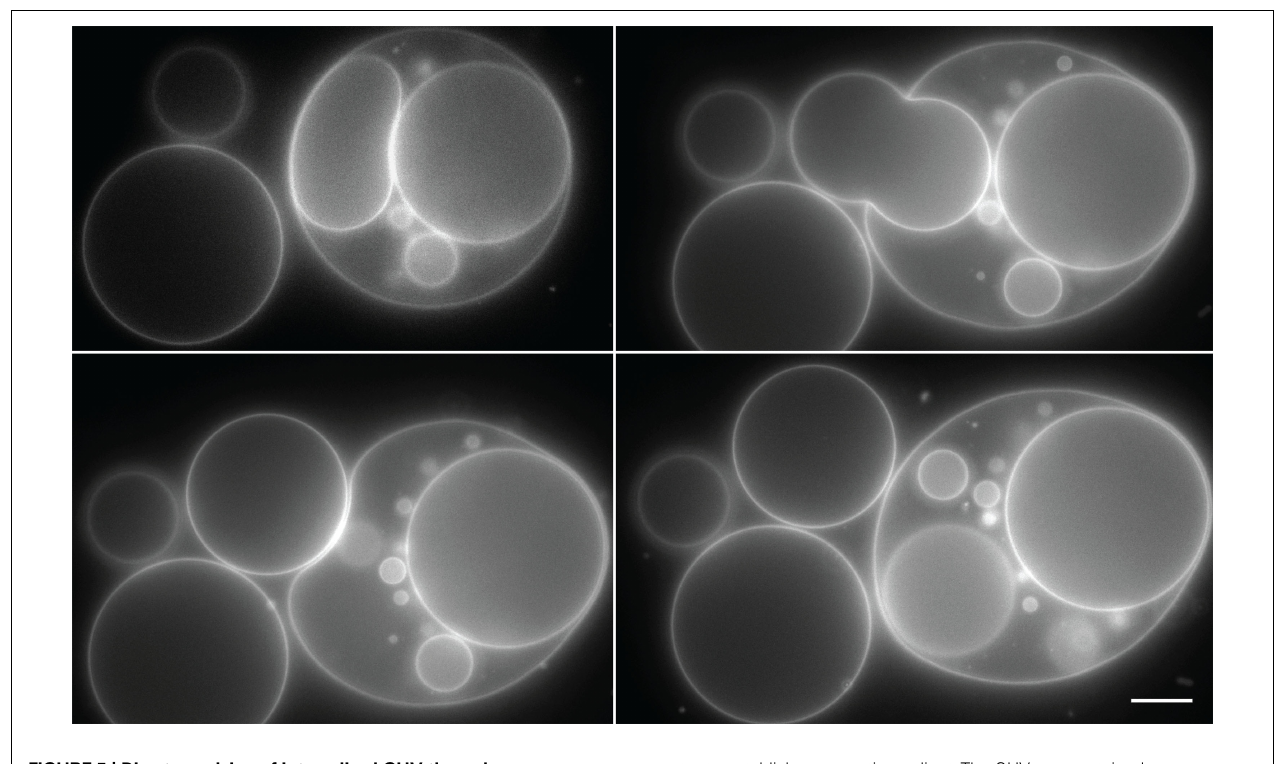
FIGURE 5 | Direct expulsion of internalized GUV through a transient pore. POPC:SM:Ch:GM1 (45:30:25:8) GUVs, loaded with a saturated galactose solution, were diluted with MilliQ